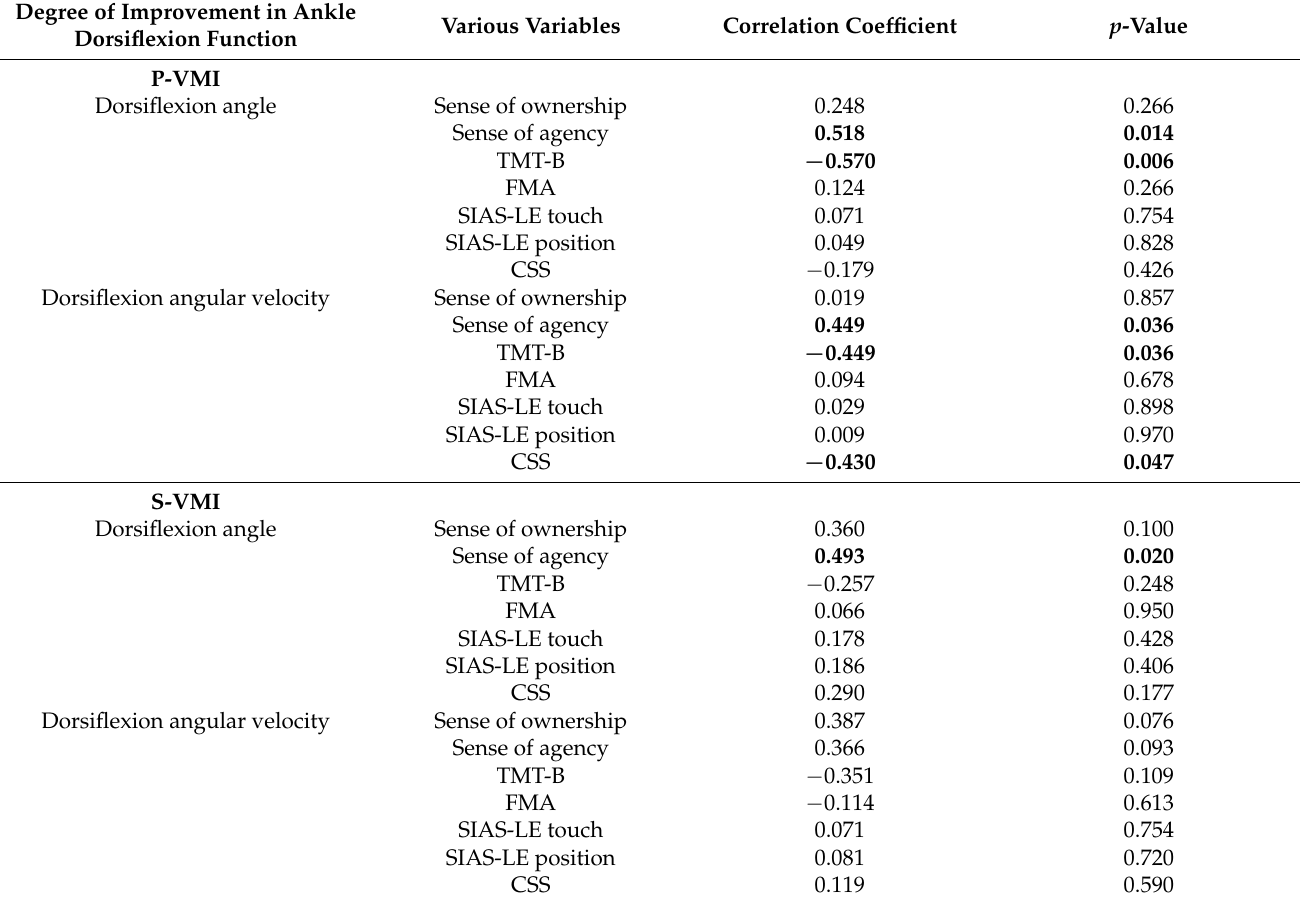
Table 4. Results of correlation analysis between degree of improvement in ankle dorsiflexion function by VMI and various